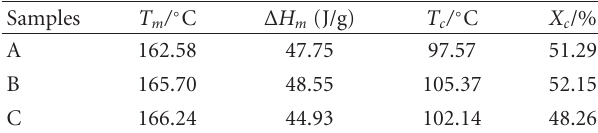
Table 1: The DSC data of di ff erent PLA